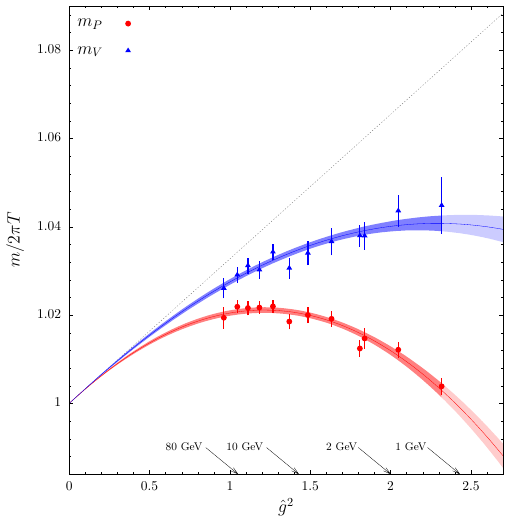
Figure 5 . Pseudoscalar (red) and vector (blue) screening masses versus ˆ g 2 . The bands represent the best fits in eqs. (7.2) and (7.4), while the dashed line is the analytically known